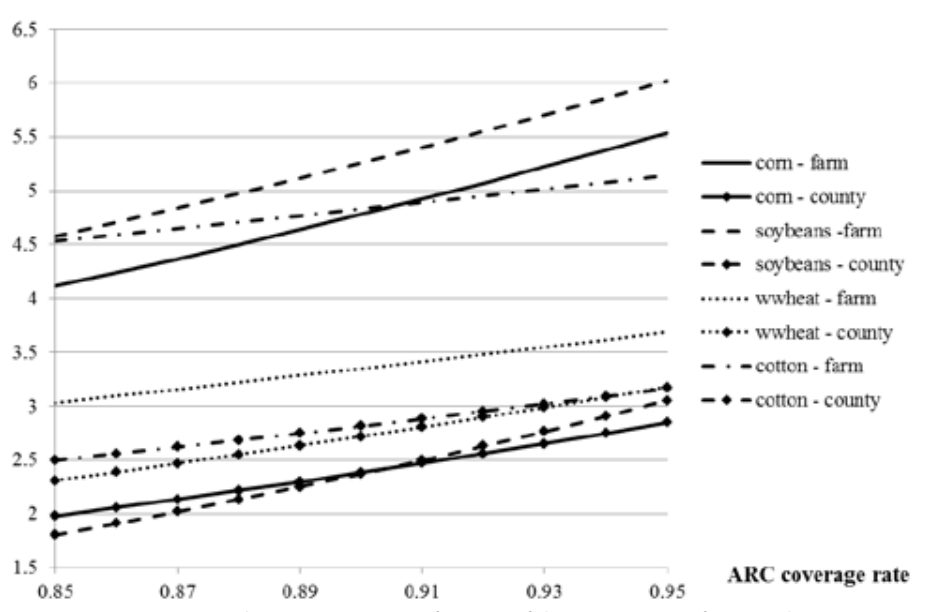
Figure 1. Average National ARC payments as a function of the coverage rate factor in the ACR’s “Guar- antee